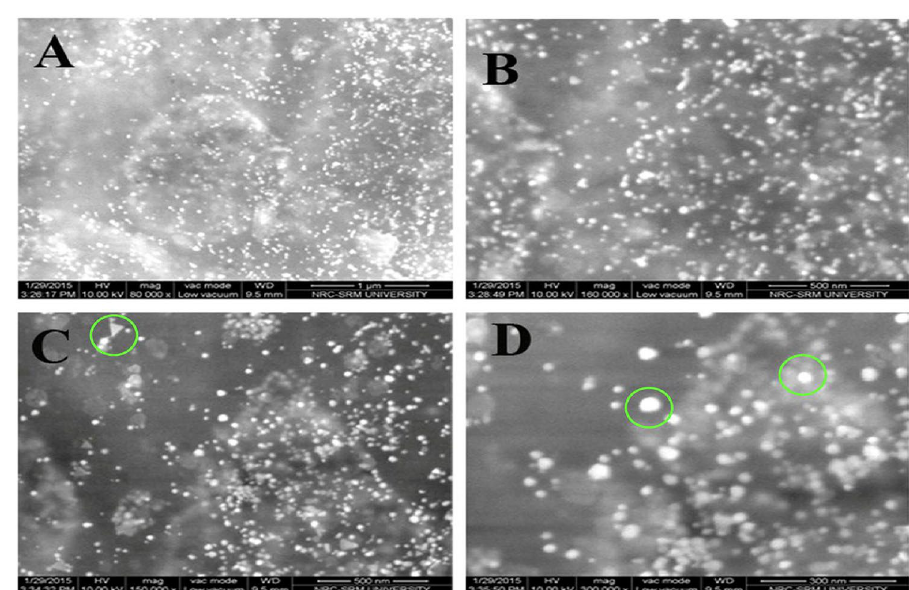
Figure 4. FESEM image of gold nanoparticles synthesized using mangostan peel extract ( A ) 1 µm, ( B ) 500 nm, ( C ) 500 nm, ( D ) 300